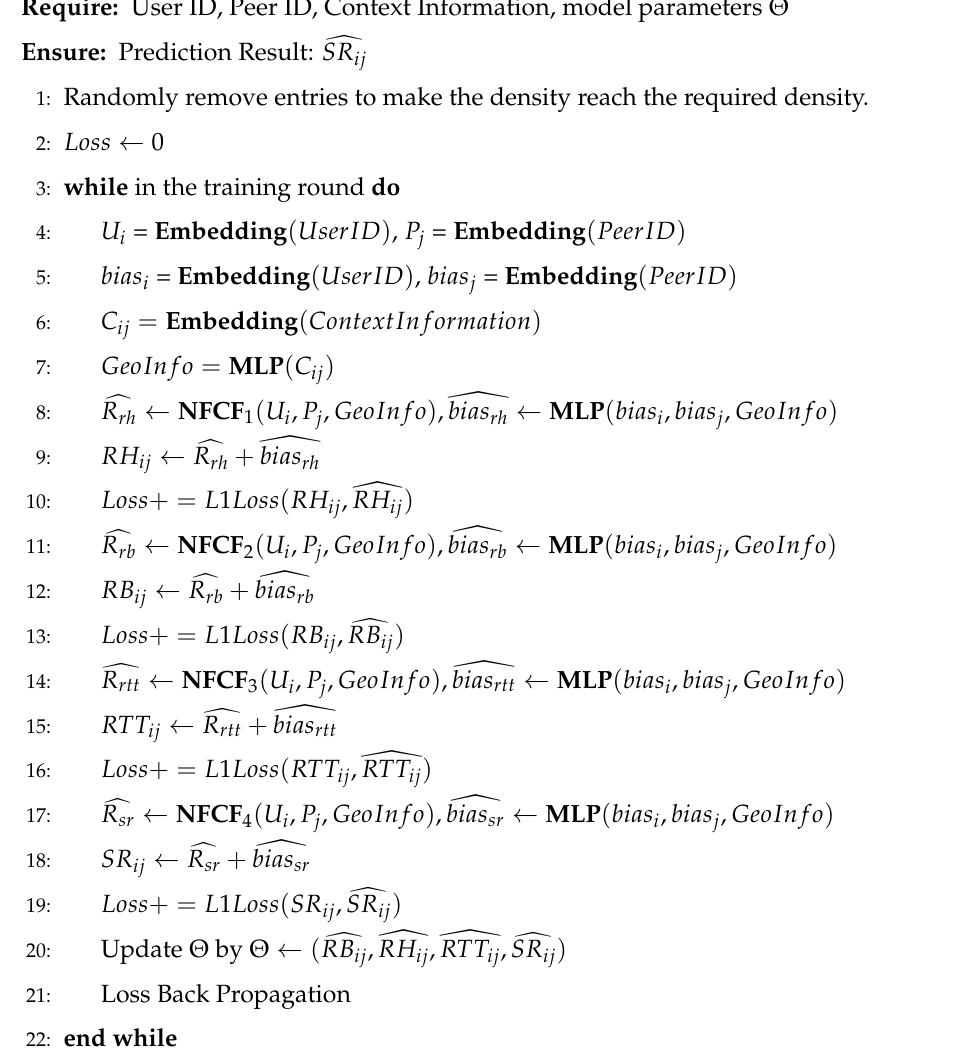
Algorithm 1 MNCF